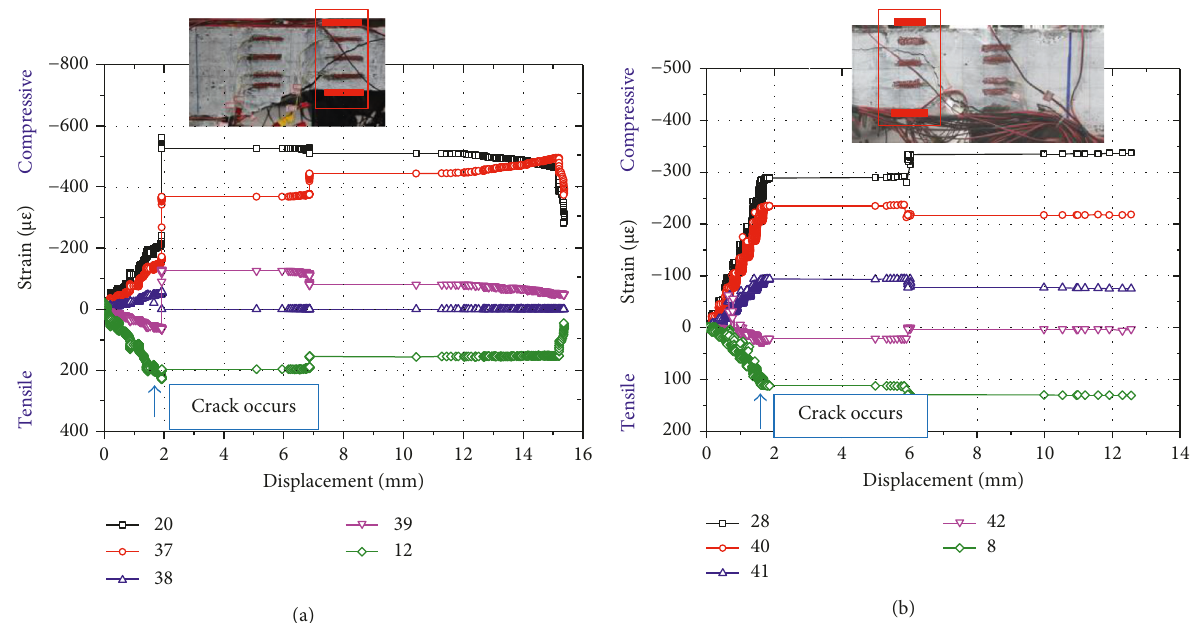
Figure 17: Strain results of P1 and P2 specimens under different displacements at Section B. (a) P1. (b)